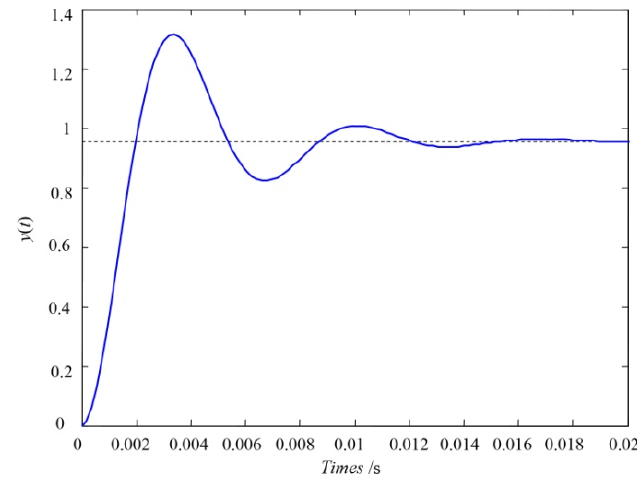
Figure 6. Step response curve of original system.